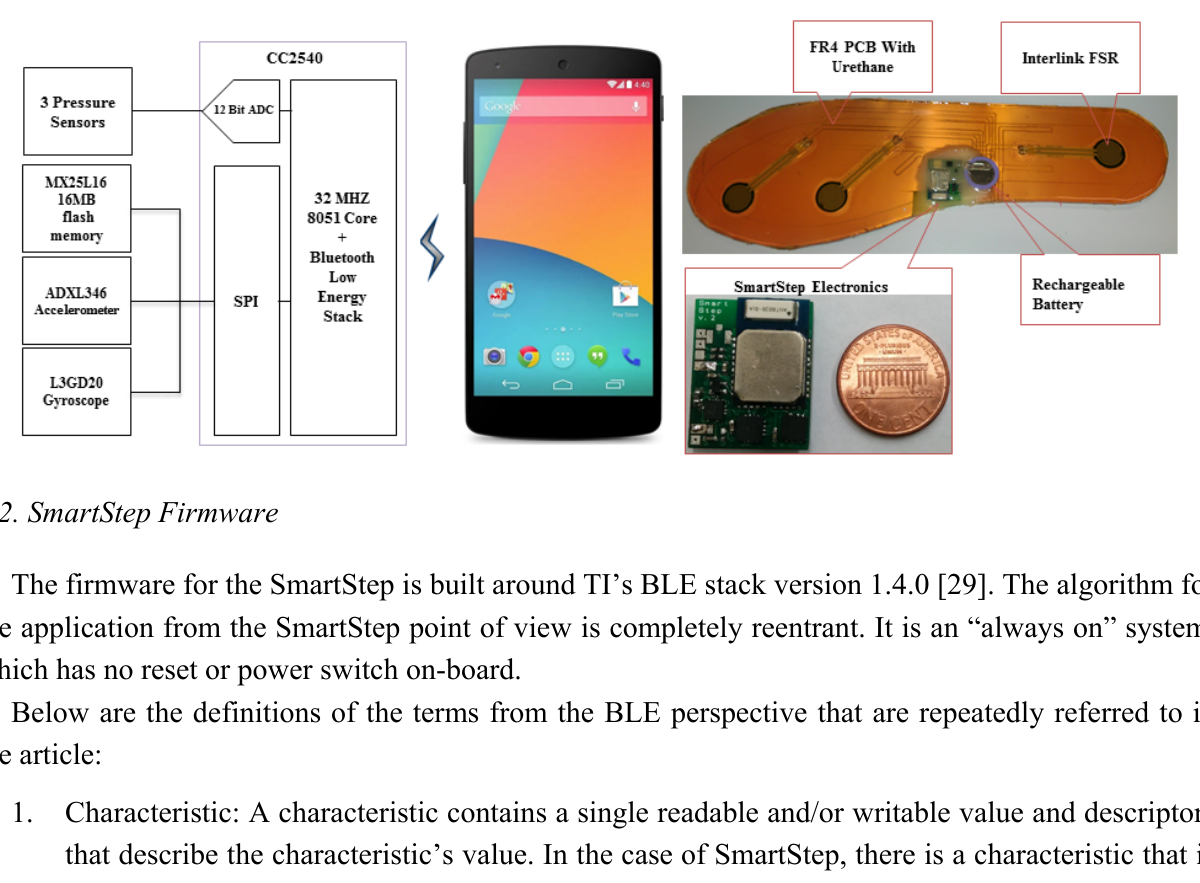
Figure 1. SmartStep block diagram and fully encapsulated sensor-equipped